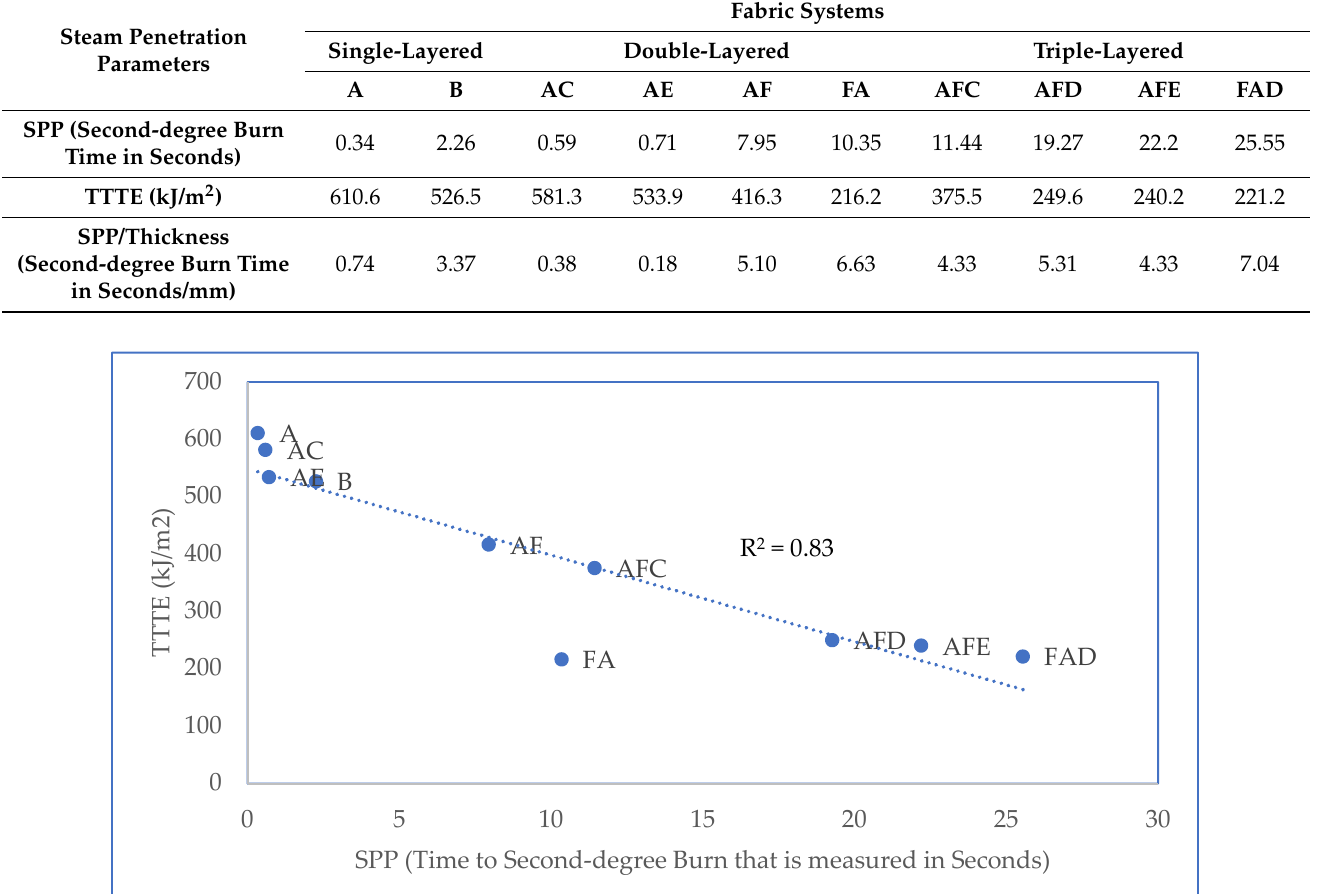
Figure 2. Relationship plot between SPP and TTTE.